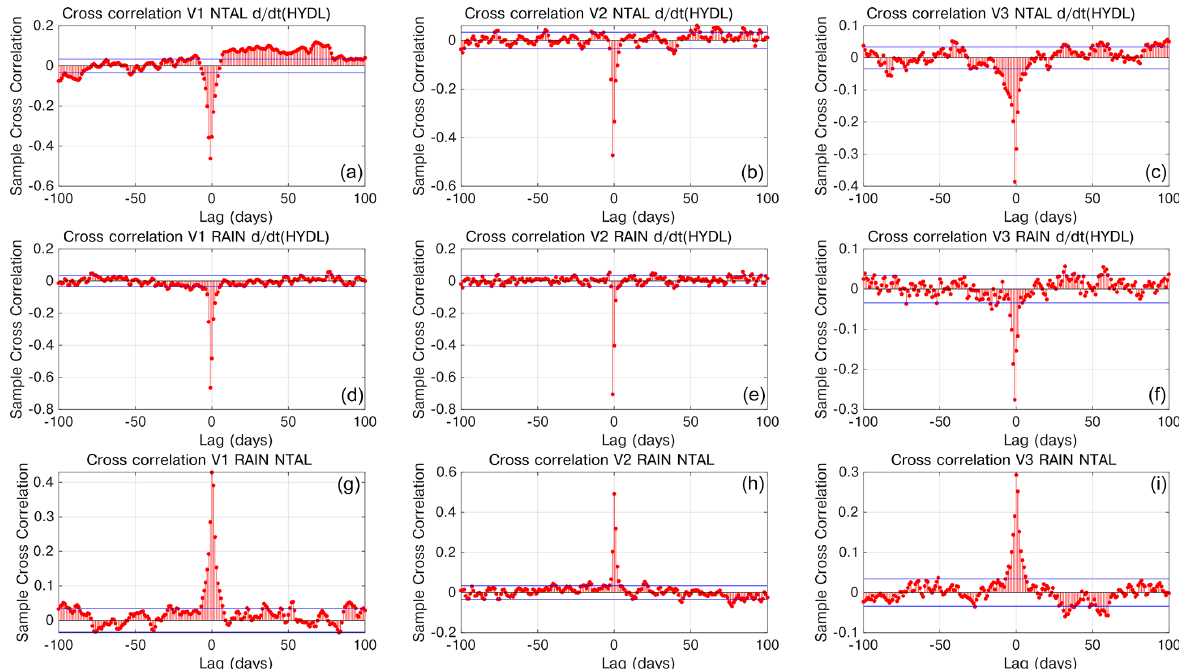
Figure 15. (a) Cross correlation between the temporal evolution of the IC1 of the NTAL decomposition and the time derivative of the temporal evolution of the IC1 obtained by decomposing HYDL. Panel (b) is the same as (a) but referring to IC2. Panel (c) is the same as (a) but referring to IC3. (d) Cross correlation between the temporal evolution of the IC1 of the precipitation data decomposition and the time derivative of the temporal evolution of the IC1 obtained by decomposing HYDL. Panel (e) is the same as (d) but referring to IC2. Panel (f) is the same as (d) but referring to IC3. (g) Cross correlation between the temporal evolution of the IC1 of the NTAL decomposition and the temporal evolution of the IC1 of the precipitation data decomposition. Panel (h) is the same as (g) but referring to IC2. Panel (i) is the same as (g) but referring to IC3.